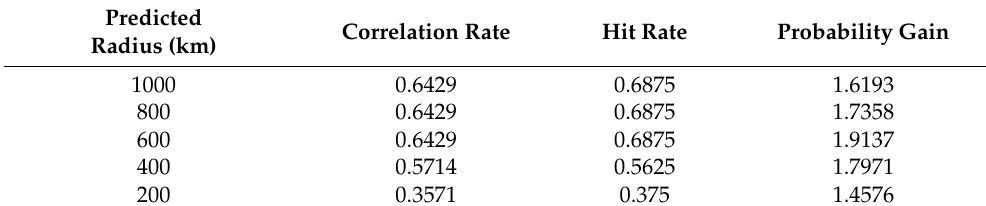
Table 6. The correlation rate, the hit rate, and the probability gain with different parameters.